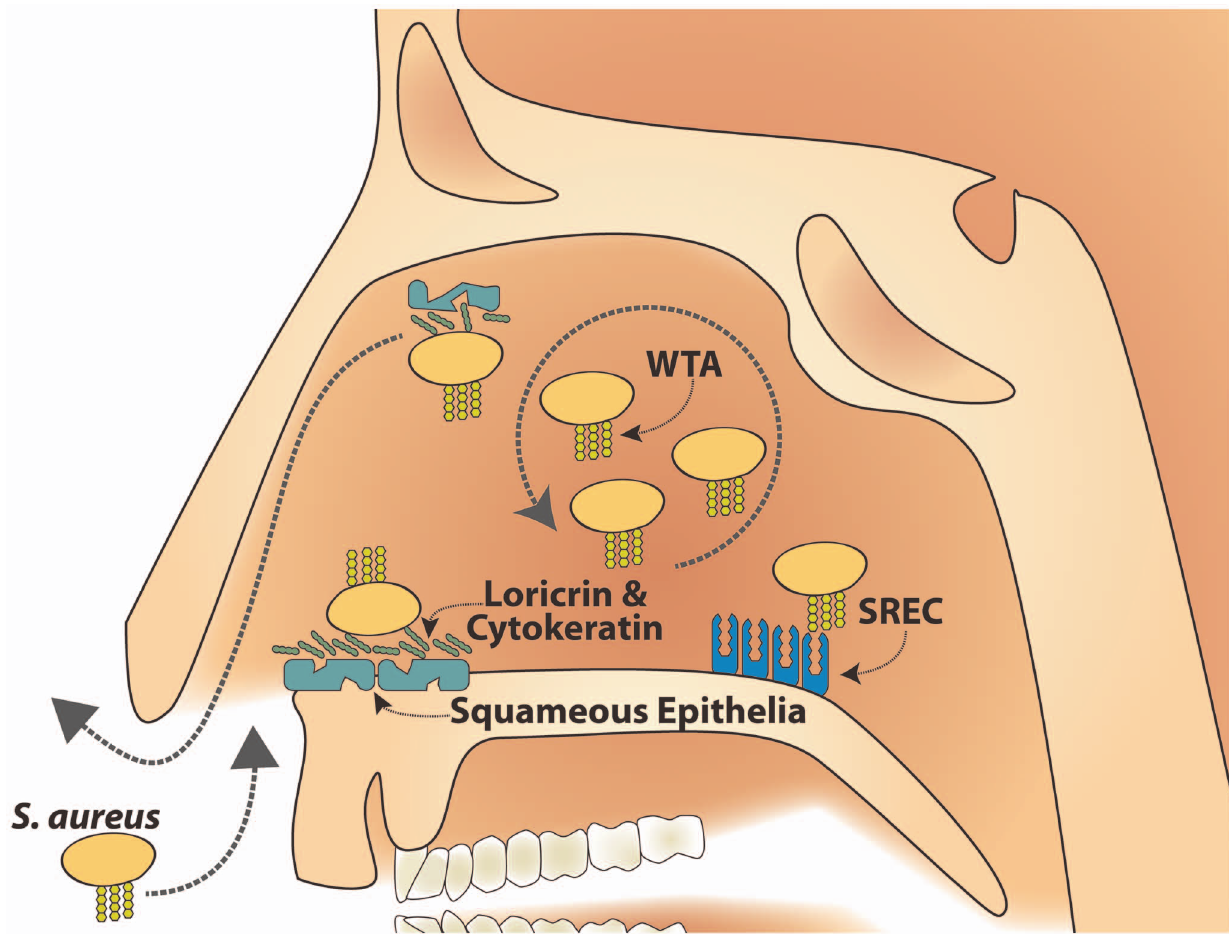
Figure 7. Model of SREC-I role in nasal colonization. SREC-I can be detected on growing nasal epithelial cells in the inner nasal cavity. S. aureus WTA binds to SREC-I which mediates S. aureus adhesion to cells from the inner nasal cavity. This WTA/SREC-I interaction has a considerable impact on nasal colonization. Therefore, we postulate a reservoir of S. aureus cells in the inner nasal cavity as a source for continuous colonization, which is at least partially maintained by WTA dependent adhesion to epithelial